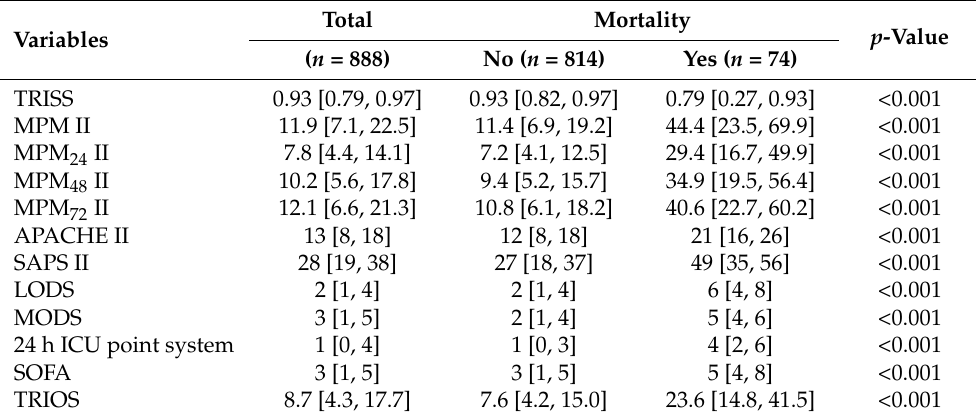
Table 3. The scores of various prognosis prediction algorithms for the death and survival adult trauma patients who were admitted into the intensive care unit.